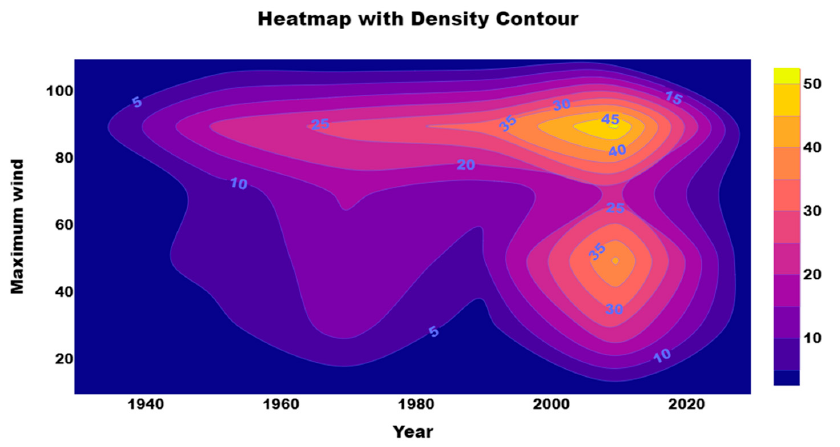
Figure 4. Scatter plot of large storm counts.